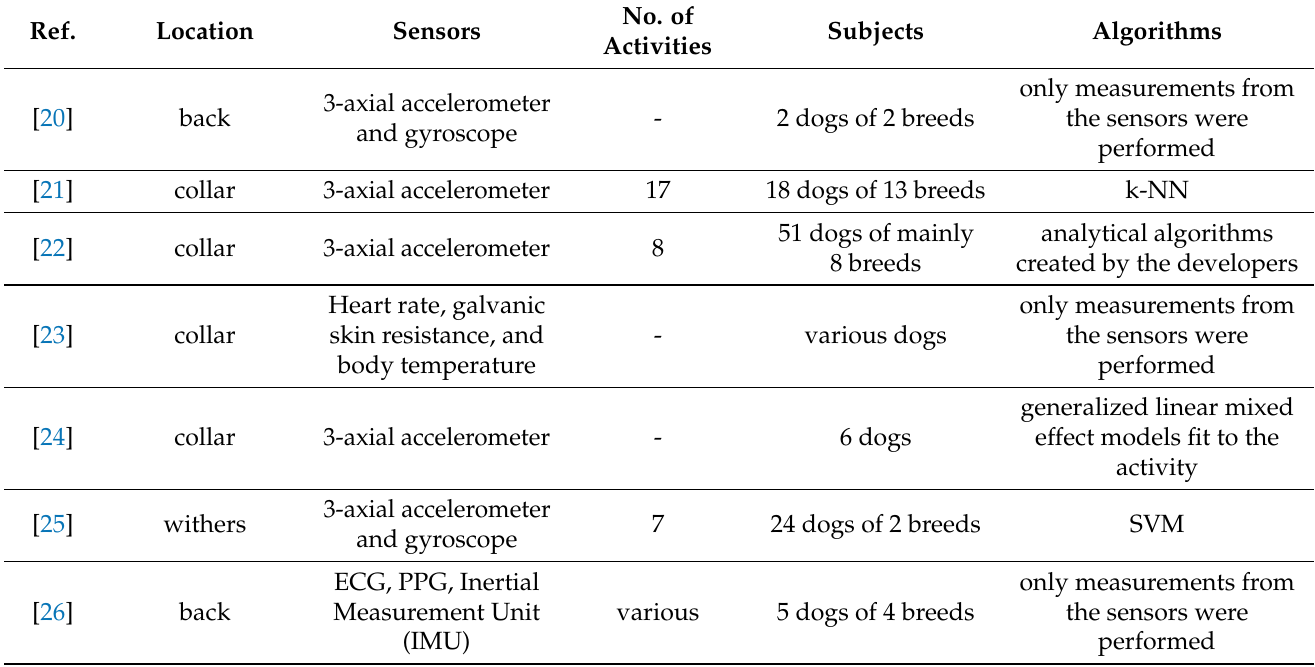
Table 1. Summary of related work on Dog Activity Recognition